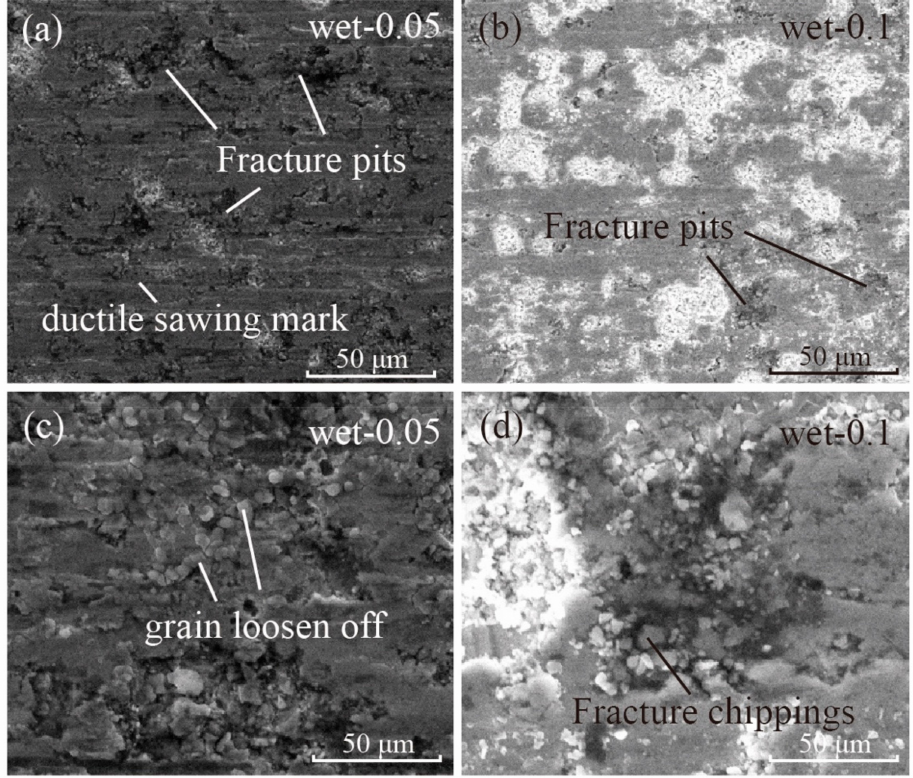
Figure 12. SEM images of the saw surface from the ( a , c ) 0.05 mm/min and ( b , d ) 0.1 mm/min groups. To explain why more fracture behavior, especially the falling off of the grain, can be found in the 0.05 mm/min group, the average removal depth per grit needs to be calculated. As shown in Figure 13, during diamond wire sawing of the NdFeB magnet, two different material removal processes can be found. Depending on the protrusion height of each